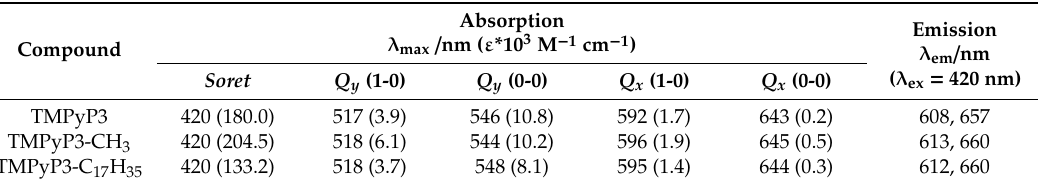
Table 2. Absorption and fluorescence emission characteristics of porphyrins TMPyP3, TMPyP3-CH 3 and TMPyP3-C 17 H 35 (10 µ M) in tap water. Molar extinction coe ffi cients ( ε ) were calculated using the Beer–Lambert